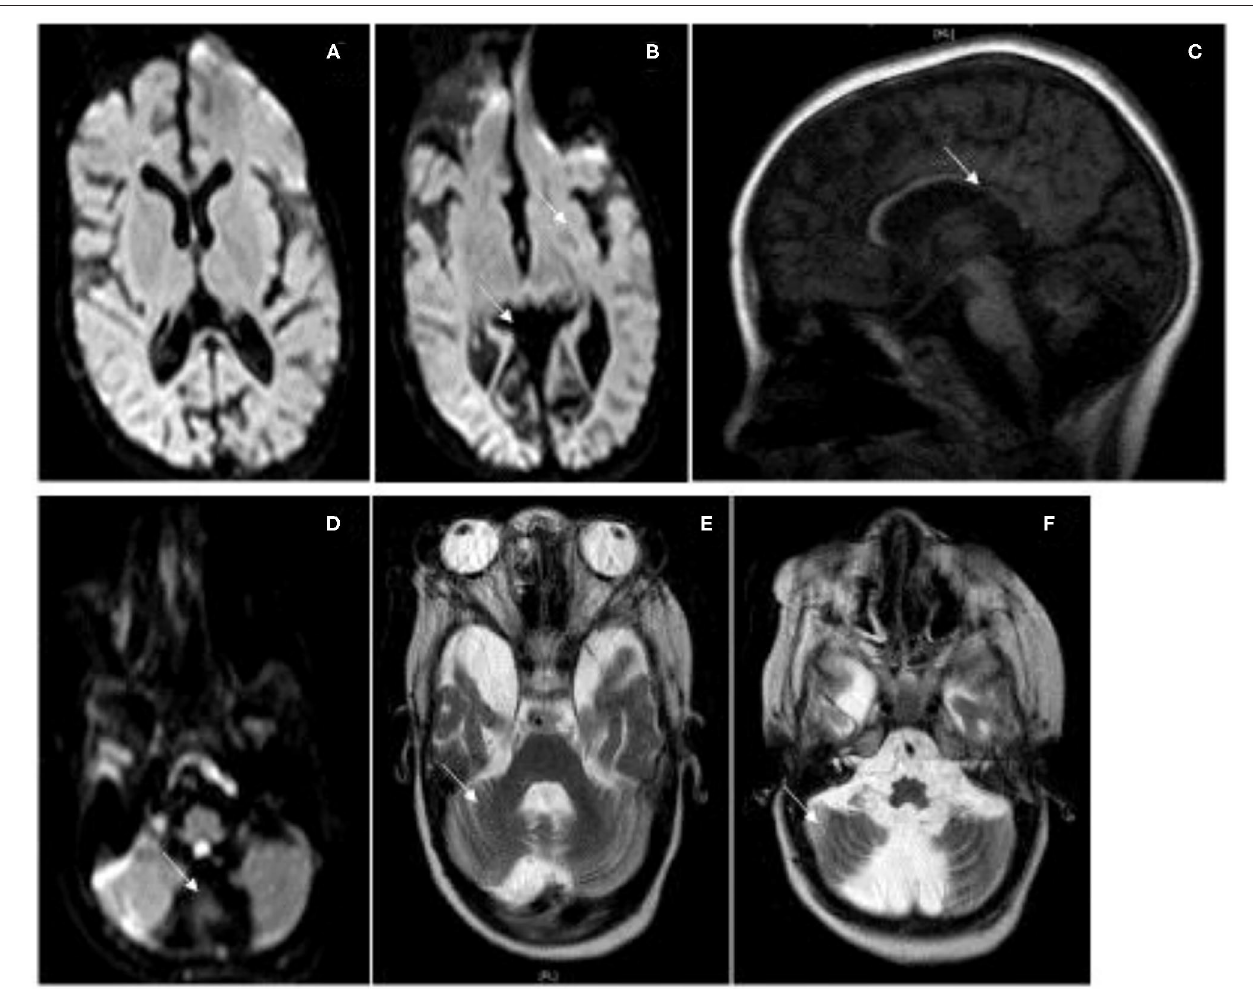
FIGURE 2 | MRI Images. Cranial MRI of patient I at the age of 10 years. (A,B) Flair, (C) T1, (D) Flair, (E,F) T2. MRI shows severe atrophy of the cerebral cortex especially of the occipital cortex and a severe atrophy of the cerebellar hemispheres with a loss of the cerebellar vermis, a thin corpus callosum, and optical atrophy.